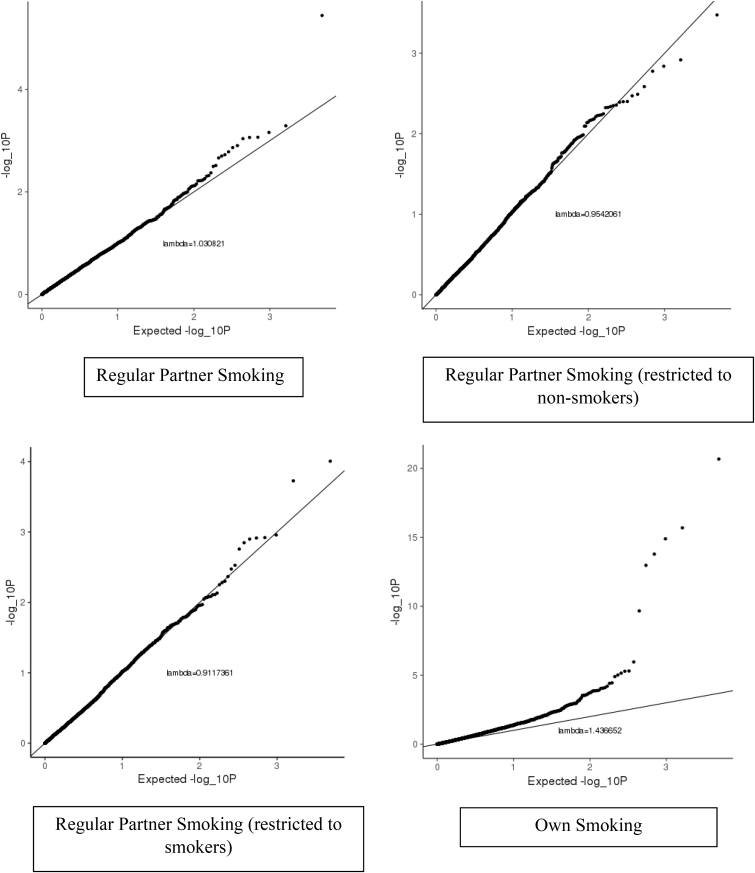
QQ plots and lambda values of DNA methylation at CpG sites previously associated with smoking in relation to partner and own smoking in Understanding Society.